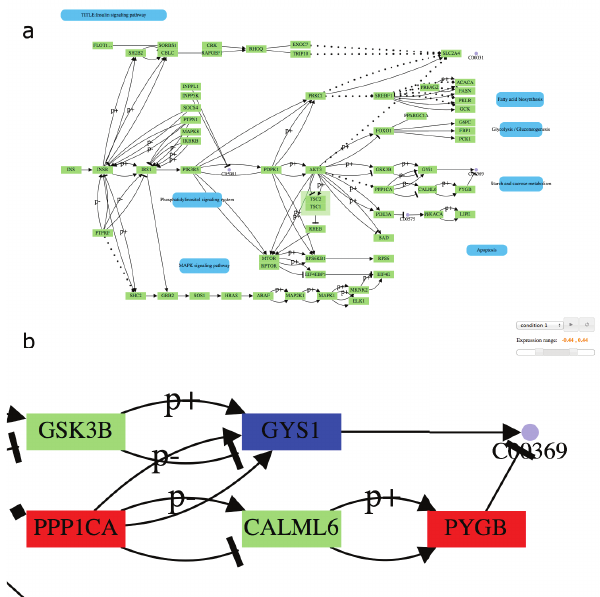
Figure 1. ( a ) KEGGViewer rendering of the insulin signaling pathway. Pathway components can be manually repositioned. Genes and pathways are represented as green and blue boxes respectively while purple dots represent chemical compounds. Relationships represent reactions e.g. activation, inhibtion or phosphorilation. ( b ) Zoomed view of the insulin signaling pathway. Condition 1 is selected in the control panel (top right) and the expression range is set to consider expression levels between -0.43 and 0.43 to be non differentially expressed. Genes PPP1CA and PYGB in red are upregulated while GYS1 in blue is downregulated. GSK3B and CALML6 in green are non differentially expressed genes. The purple dot C00369 represents